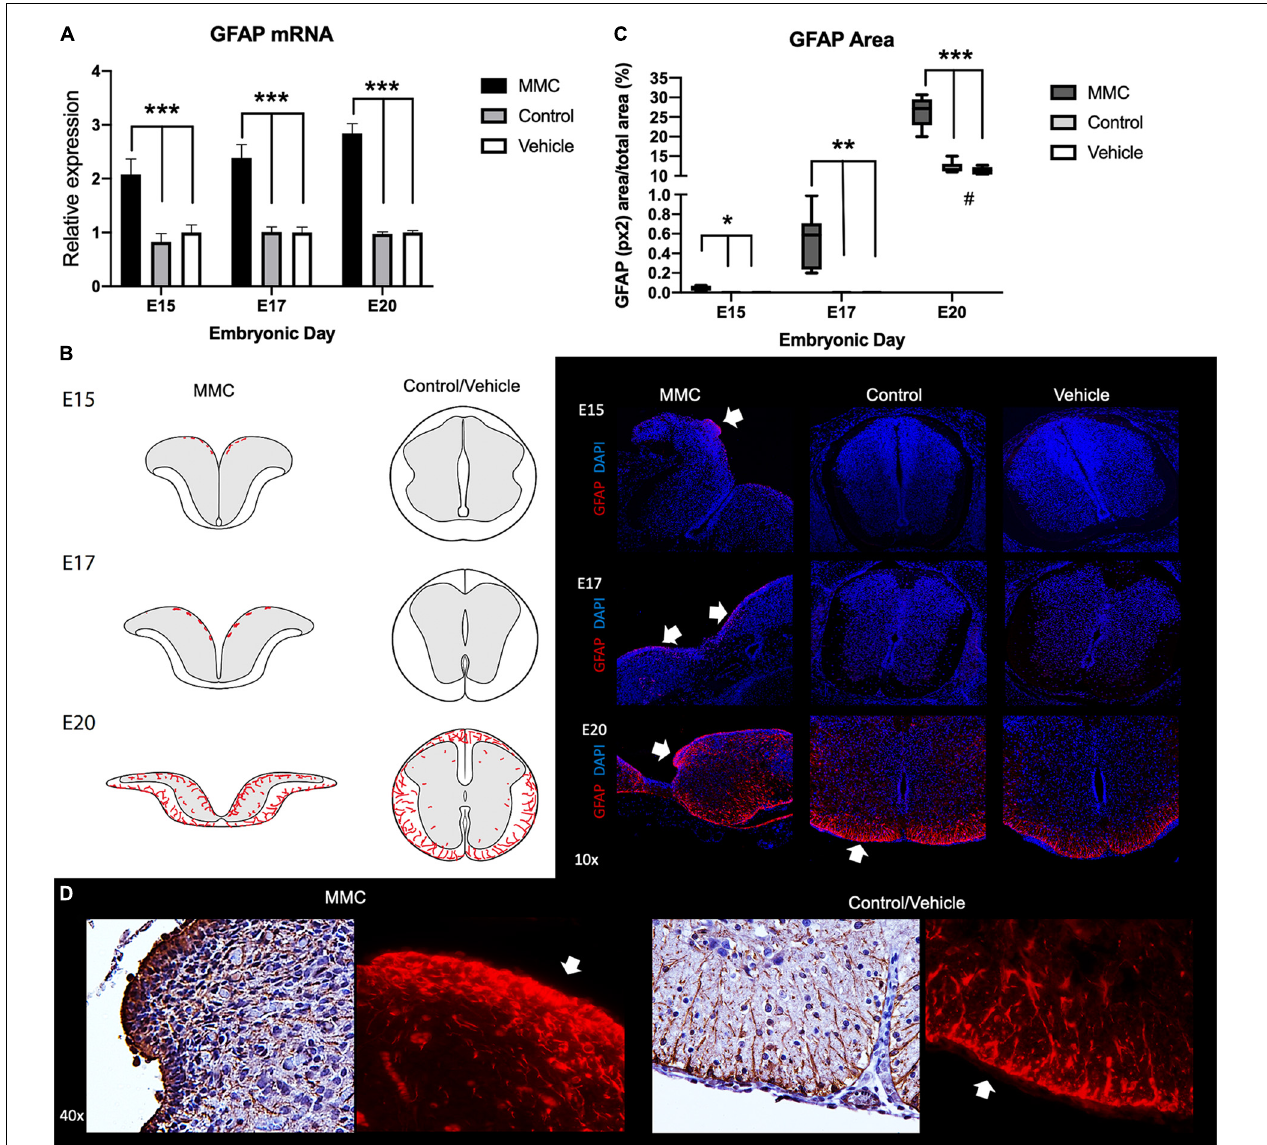
FIGURE 1 | Progressive immunoreactive astrocytes in spina bifida fetuses. (A) GFAP relative expression increased in spina bifida (MMC) compared with control and vehicle spinal cords. Values (means ± SE, 6 fetuses/group) of relative expression (2 – (cid:49)(cid:49) Ct ) for RA-treated and time-matched controls (*** p < 0.001). (B) Schematic representation of GFAP distribution in MMC and control fetal spinal cords at E15, E17, and E20 (left). GFAP staining (right) in MMC, control, and vehicle fetal spinal cords at E15, E17, and E20. Progressive GFAP+ (red) DAPI+ (blue) immunoreactive astrocyte cells at E15, E17, and E20 in exposed spina bifida (arrows) (10 × images). (C) GFAP stained area/total picture area in all groups at three gestational ages E15, E17, and E20 (means ± SD, * p < 0.05, ** p < 0.01, *** p < 0.001, # p < 0.05 between control and vehicle groups at E20 compared to E15 and E17). (D) GFAP-immunoreactive astrocytes in spina bifida (MMC) VZ exposed to the amniotic fluid compared to filamentous astrocyte projections in white matter control spinal cords at E20